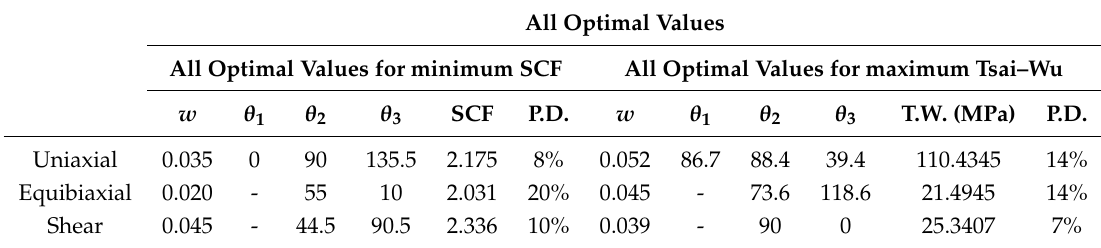
Table 11. Optimal values of all design variables for square cutout ( c =